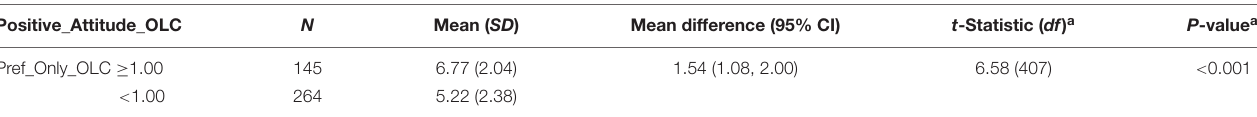
TABLE 1 | Mean and standard deviations scores Positive_Attitude_OLC Group